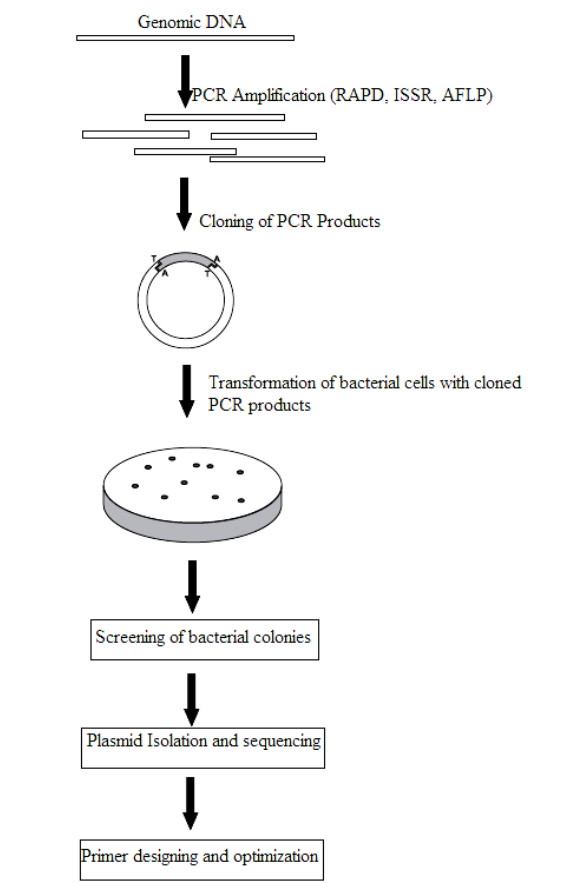
Fig. 3. Protocol for the development of SSR markers through cloned PCR products (modified scheme from Zane et al .,